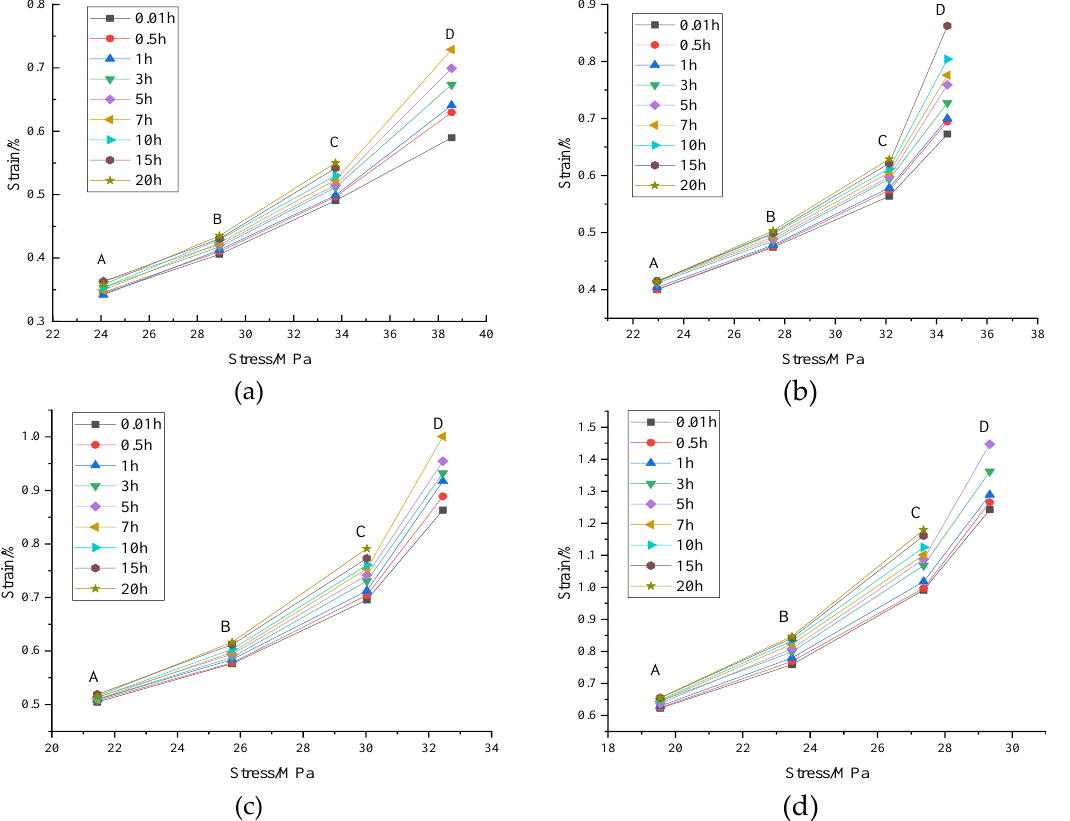
Figure 8. Isochronous stress – strain curves under different seepage pressures. ( a ) Seepage pressure of 0 MPa. ( b ) Seepage pressure of 0.5 MPa. ( c ) Seepage pressure of 1.0 MPa. ( d ) Seepage pressure of 1.5 MPa.